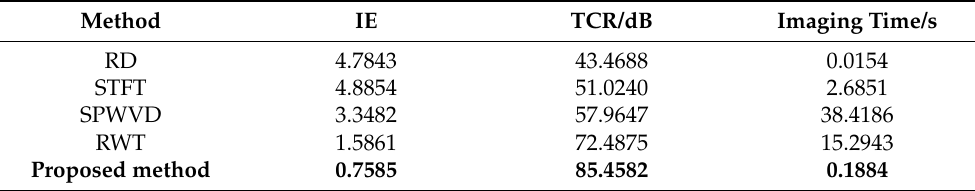
Table 3. The evaluation indicators of different methods under sparse